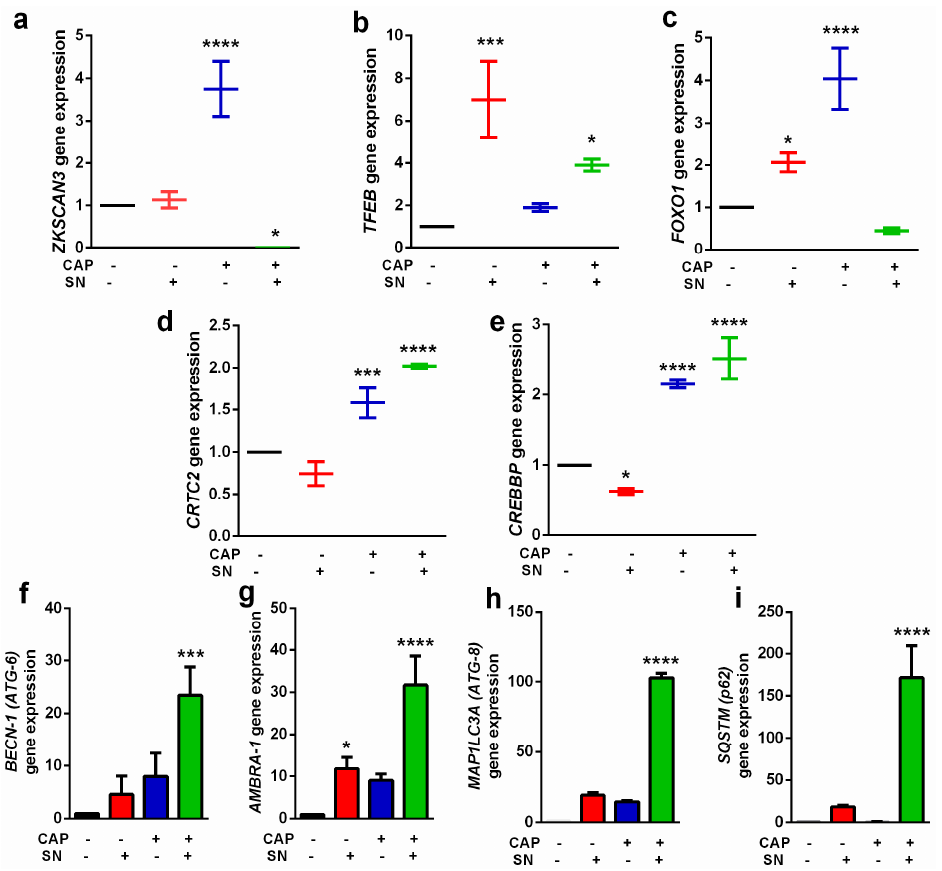
Figure 5 . Gene expression levels of autophagy-related transcriptional factors: ( a ) ZKSCAN3 gene; ( b ) TFEB gene; ( c ) FOXO1 gene; ( d ) CRTC2 gene; and ( e ) CREBBP gene. Expression of various gene levels